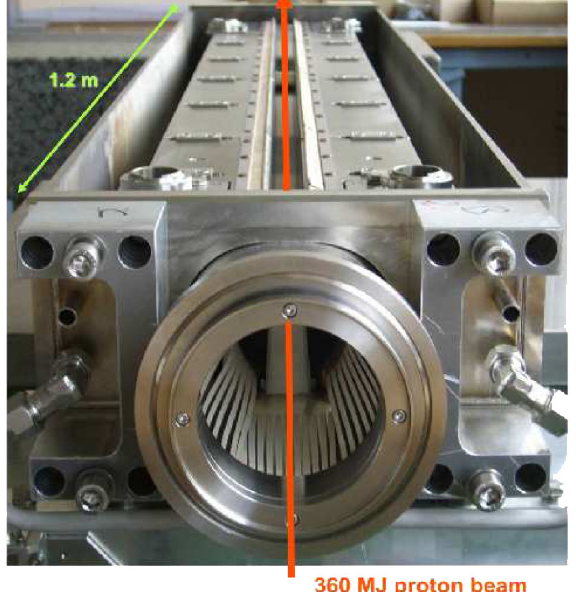
FIG. 2. LHC collimator viewed from one end, showing the beam trajectory in red (from [9]). The jaws lie inside the casing on either side of the beam, with the rf fingers in the foreground. They can be positioned with an accuracy of 5 (cid:1) m .